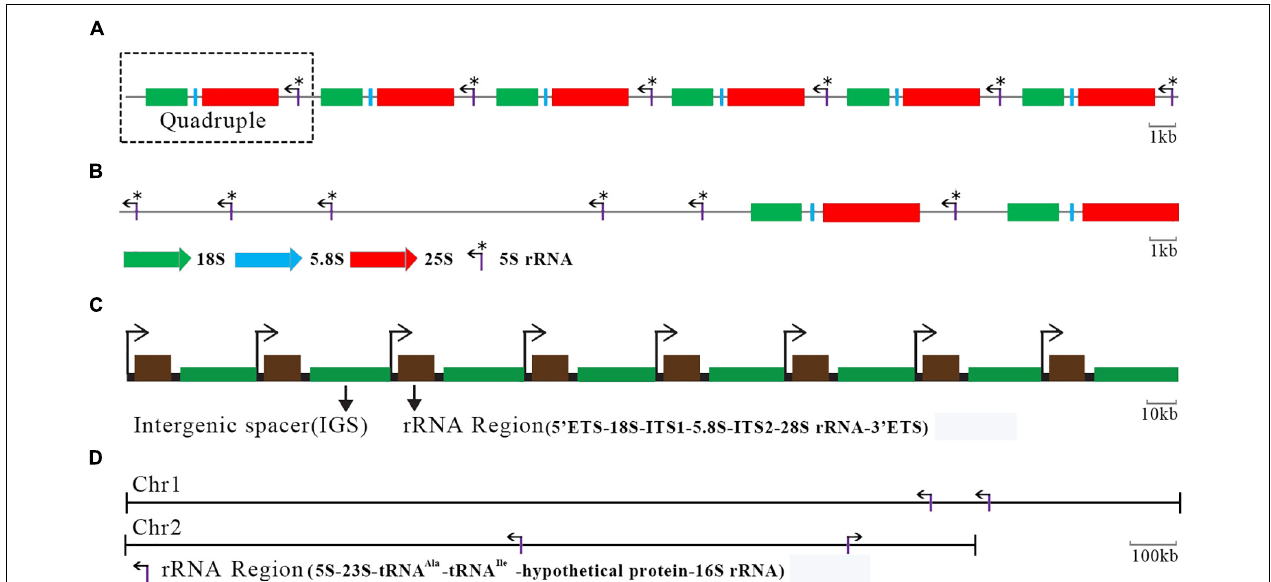
FIGURE 3 | Organization of rDNA genes in yeasts, human and bacteria. (A) The only rDNA locus is in chromosome 2 (GenBank: CP073034) of the Ogataea polymorpha HU-11/CBS4732 genome, containing 20 copies of tandem repeats (TRs). Here only six copies of TRs are shown. (B) An rDNA TR of Saccharomyces cerevisiae also contains 5S, 18S, 5.8S, and 25S rDNAs as a quadruple, repeating 2 times in chromosome 7 of its genome. Four other 5S rDNAs are located separately away from the rDNA quadruples in S. cerevisiae . (C) Each human rDNA unit has an rRNA region and an intergenic spacer (IGS). Here only eight units are shown. ITS, internal transcribed spacer; ETS, external transcribed spacers. (D) There are four copies of rRNA regions at two rDNA loci in chromosome 1 (GenBank: CP022603) and 2 (GenBank: CP022604) of the Ochrobactrum quorumnocens genome.